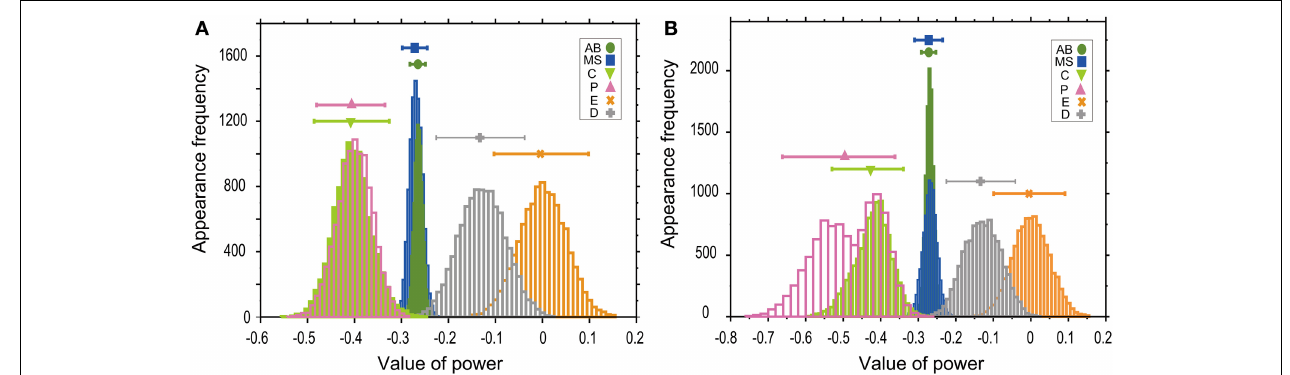
FIGURE 3 | Powers of the T–V relationship could be classified into three classes. T–V relationships in each lineage in the logarithmic (A) or linear (B) scale were fitted by a power law model. Statistical analysis combining regression analysis and a bootstrap method were performed 10,000 times, using the same data used in Figure 2 . The estimated power is indicated in